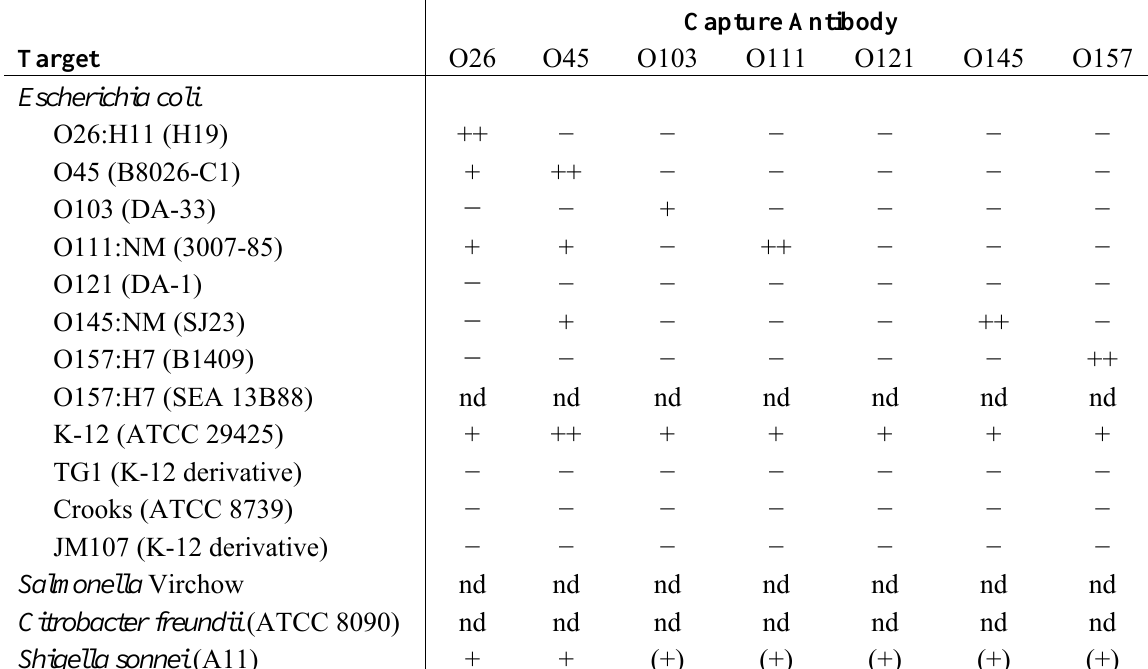
Table 1. Semi-quantitative microarray responses for target and non-target bacterial samples ( ca. 1 × 10 8 CFU/mL) reacted with low dilutions (1:10 to 1:30) of KPL purified IgGs.